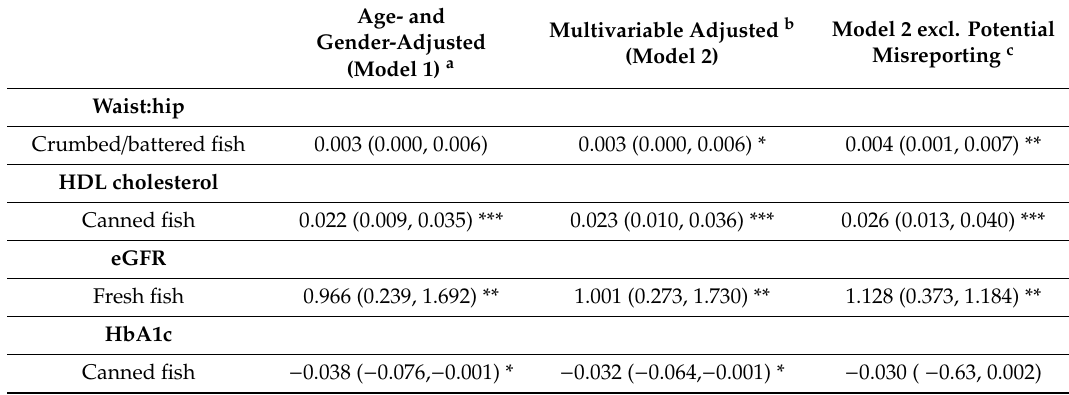
Table 5. Fish intake and modifiable cardiometabolic risk